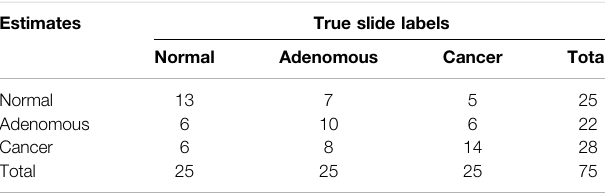
TABLE 5 | Confusion between slide classi fi cations and slide labels for seed instances.